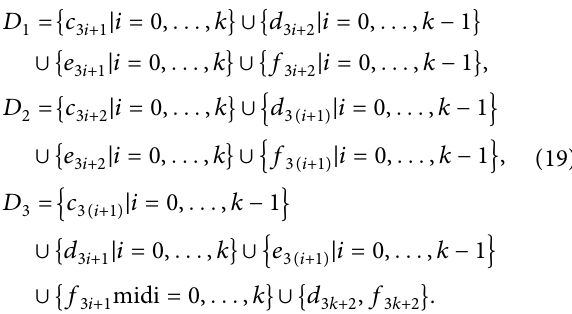
Figure 6: Te graph of D